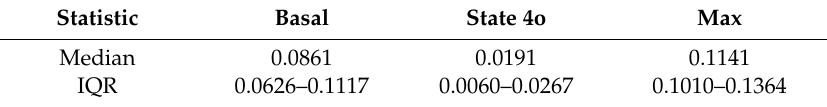
Table 2. Mitochondrial Oxygen Consumption Descriptive Statistics.